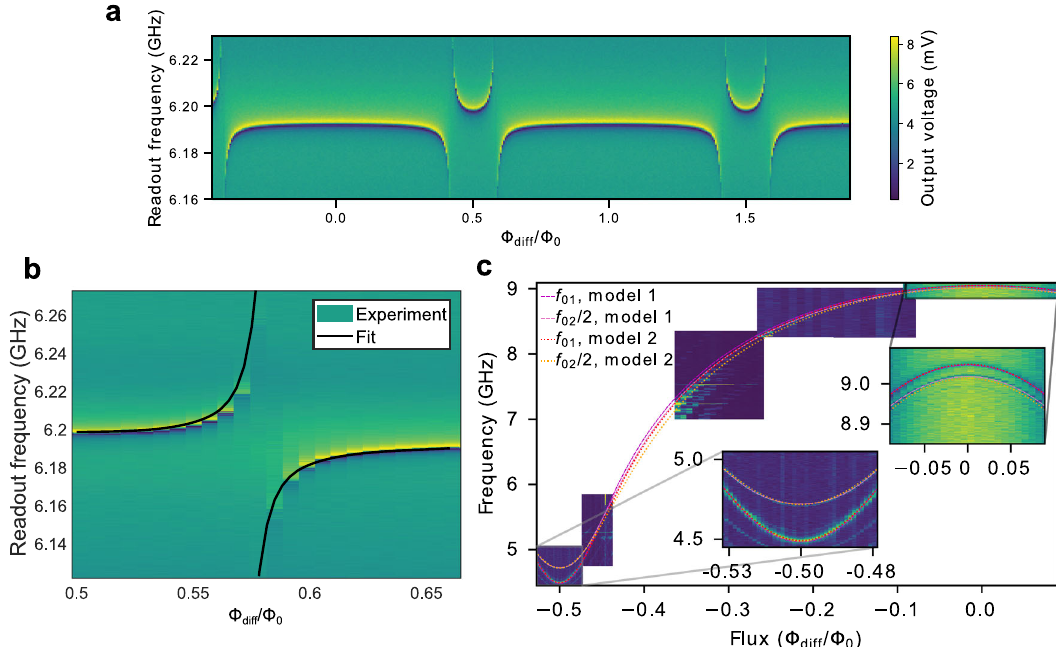
Fig. 2 | Resonator and qubit B spectroscopies.a Magnitude of the readoutsignal voltagetransmittedthroughtheprobelineasafunctionofthesignalfrequencyand the fl uxbias Φ diff oftheunimon. b Magni fi cationatanavoidedcrossingsof a ,where aunimonanditsreadoutresonatorareclosetoresonance,togetherwitha fi t(solid blackline)usedtoestimatethecouplingcapacitance C g betweenthequbitandthe resonator.The fi tisbasedondiagonalizingEq(5)in “ Methods ” . c Magnitudeofthe